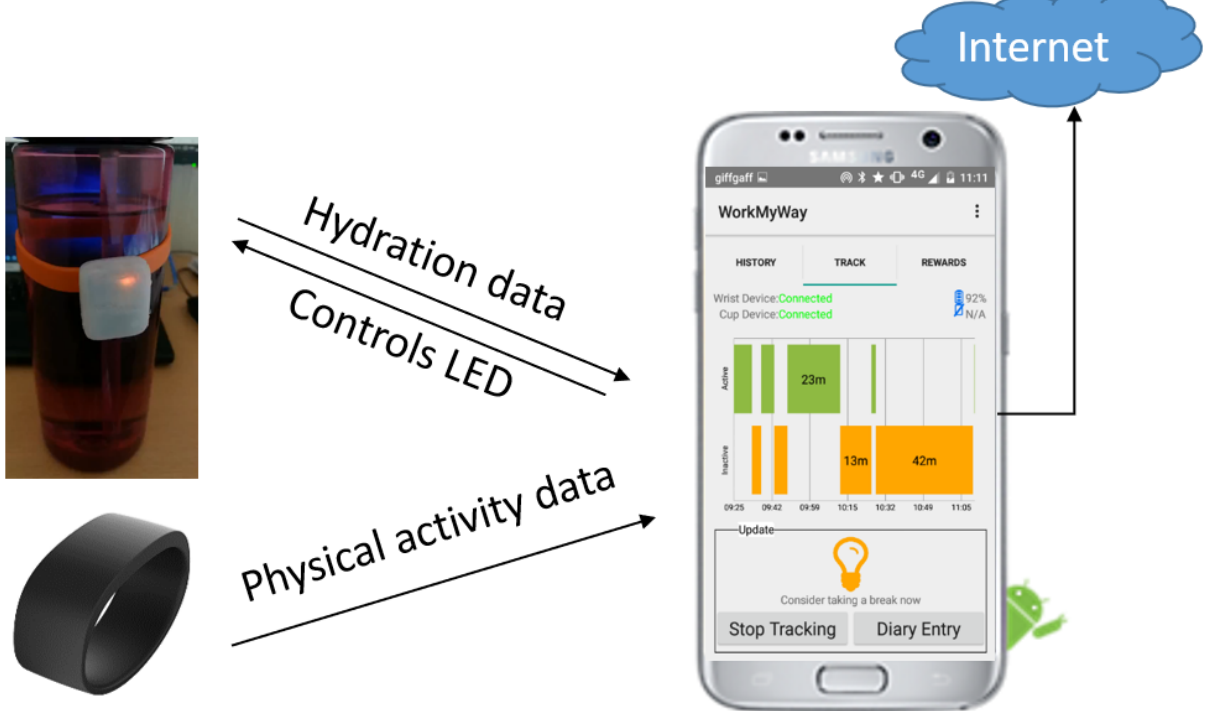
Figure 5. The resulting intervention delivery system. LED: light-emitting